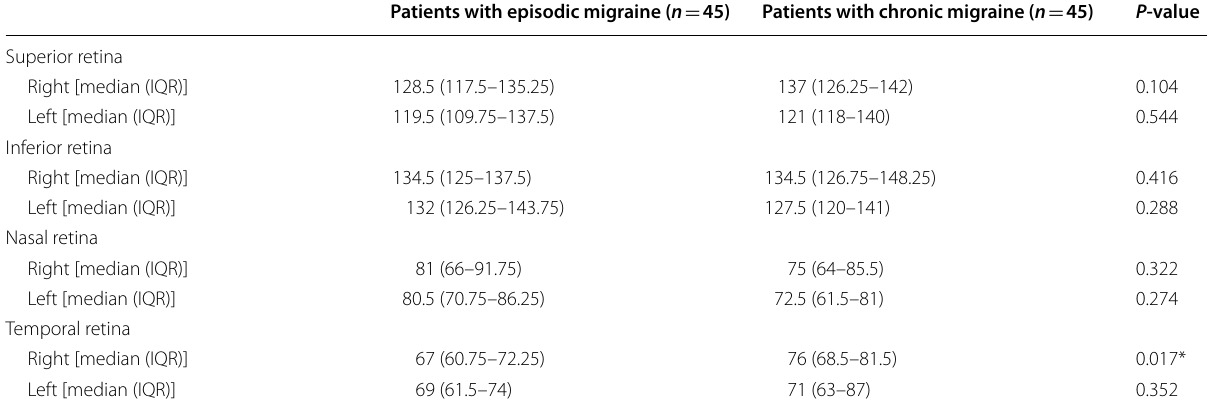
Table 4 Retinal nerve fiber layer thickness in patients with episodic migraine in comparison those with chronic migraine